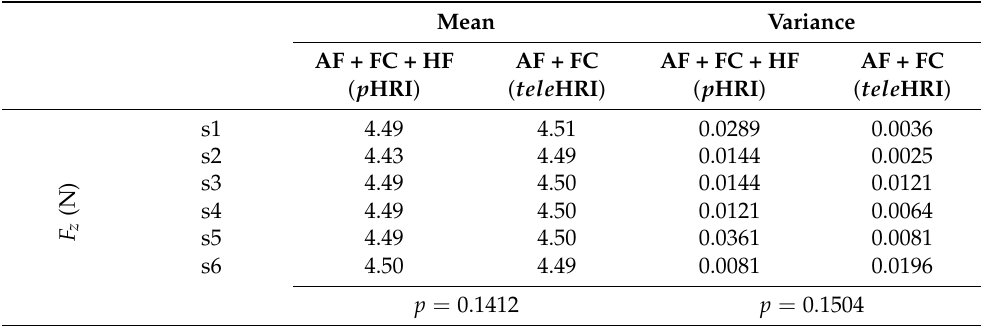
Table A4. Comparing the task performance on slope tissue surface under different feedback types in two modes when the proposed hybrid controller is implemented in Experiment 2b.